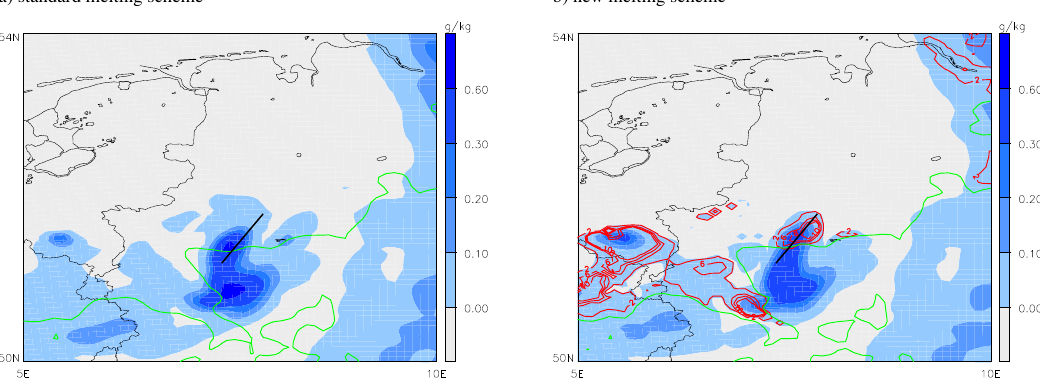
Fig. 8. Snow mixing ratio (colors, in gkg − 1 ), meltwater mixing ratio (red contours for 2, 6, 8, 10 mgkg − 1 , only in panel (b)), and the 0 ◦ C isoline (green contour) on model level 1 at 03 UTC 25 November 2005 for the simulations with (a) the standard and (b) the new snow melting scheme. The black line indicates the location of the vertical cross section shown in Fig. 7b.